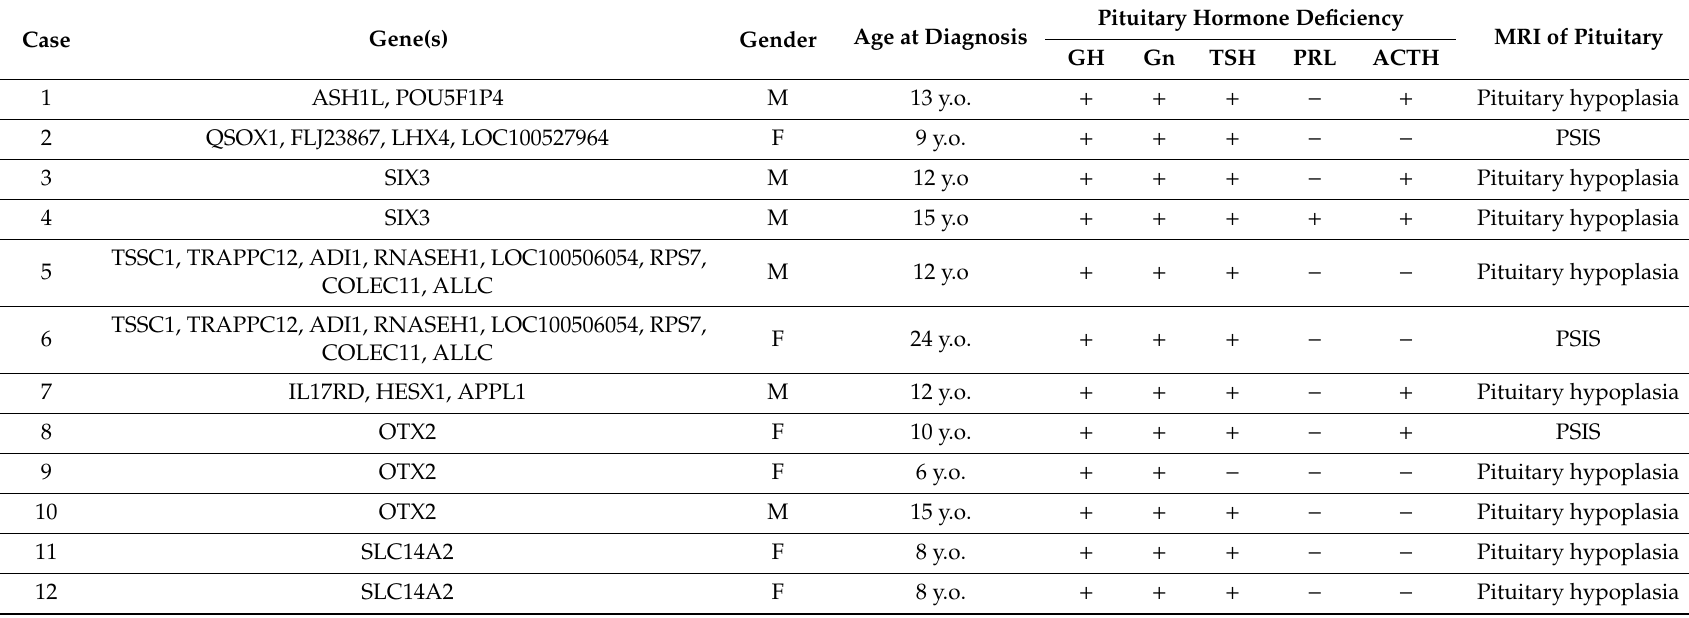
Table 2. Clinical characteristics of studied CPHD patients with genes covered by detected